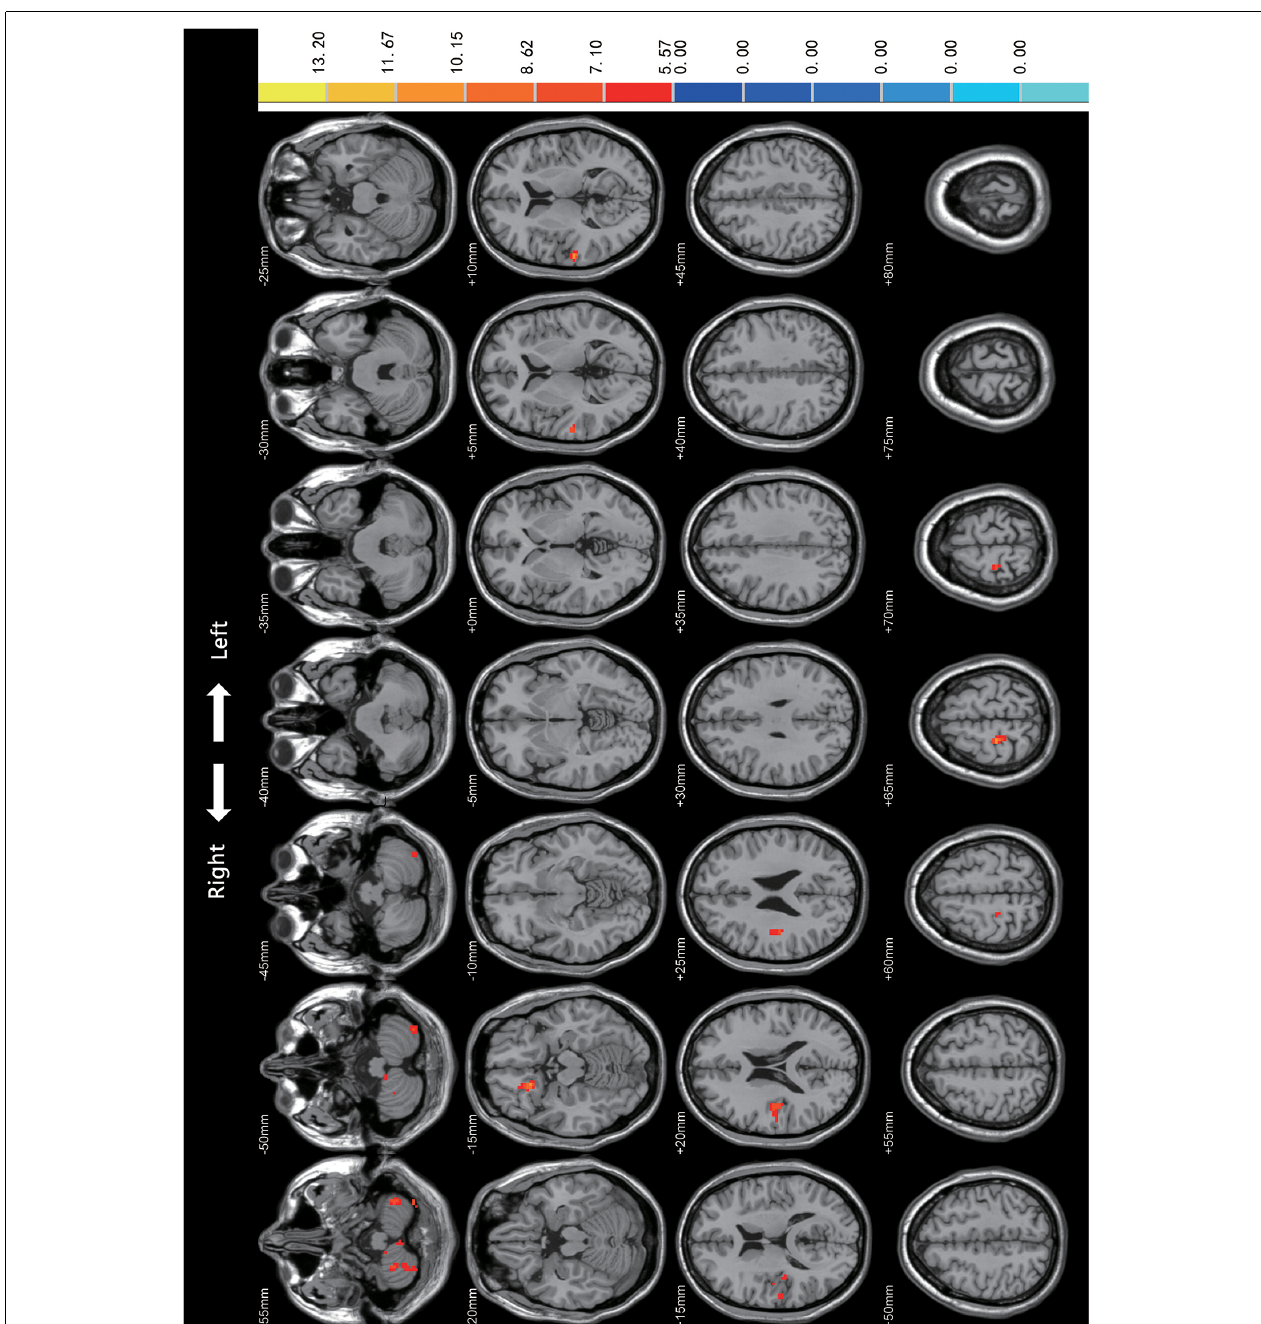
FIGURE 1 | Comparison of Regional Homogeneity (ReHo) among PD-mild, PD-moderate, and HC groups. Significant differences were revealed in the following brain regions: bilateral cerebellum (Cerebellum_8/9_R, Cerebellum_8_L, Cerebellum_Crus2_L), right superior orbital gyrus, right rectus, right superior temporal gyrus, right Rolandic operculum, right postcentral gyrus, and the right precentral gyrus ( p < 0.05).